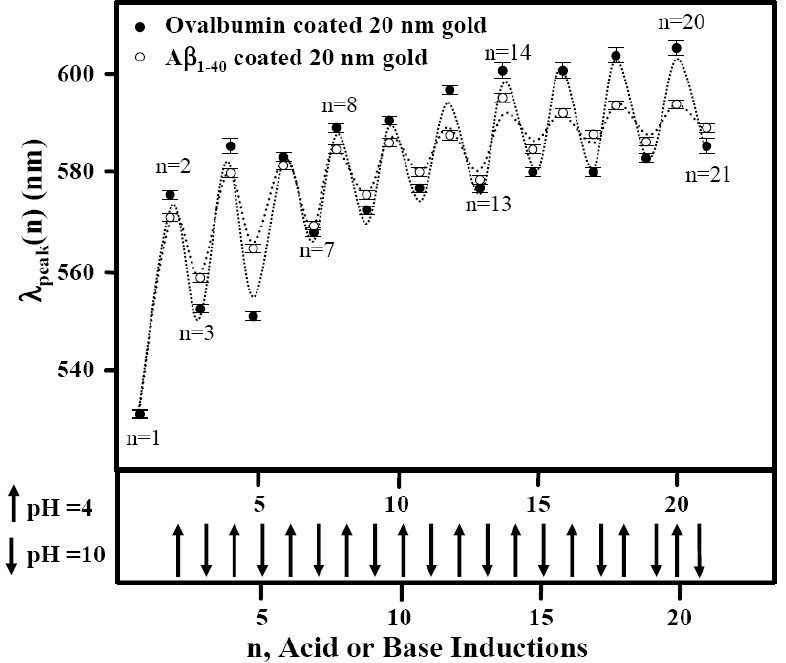
Figure 6. A demonstration of the color change reversibility seen in A  gold colloidal particles and ovalbumin coated 20 nm gold colloid. The upward and downward arrows indicate an injection of HCl and NaOH, adjusting the pH of the solution to pH 4 and pH 10, respectively. The dashed lines indicate the values predicted by Equation